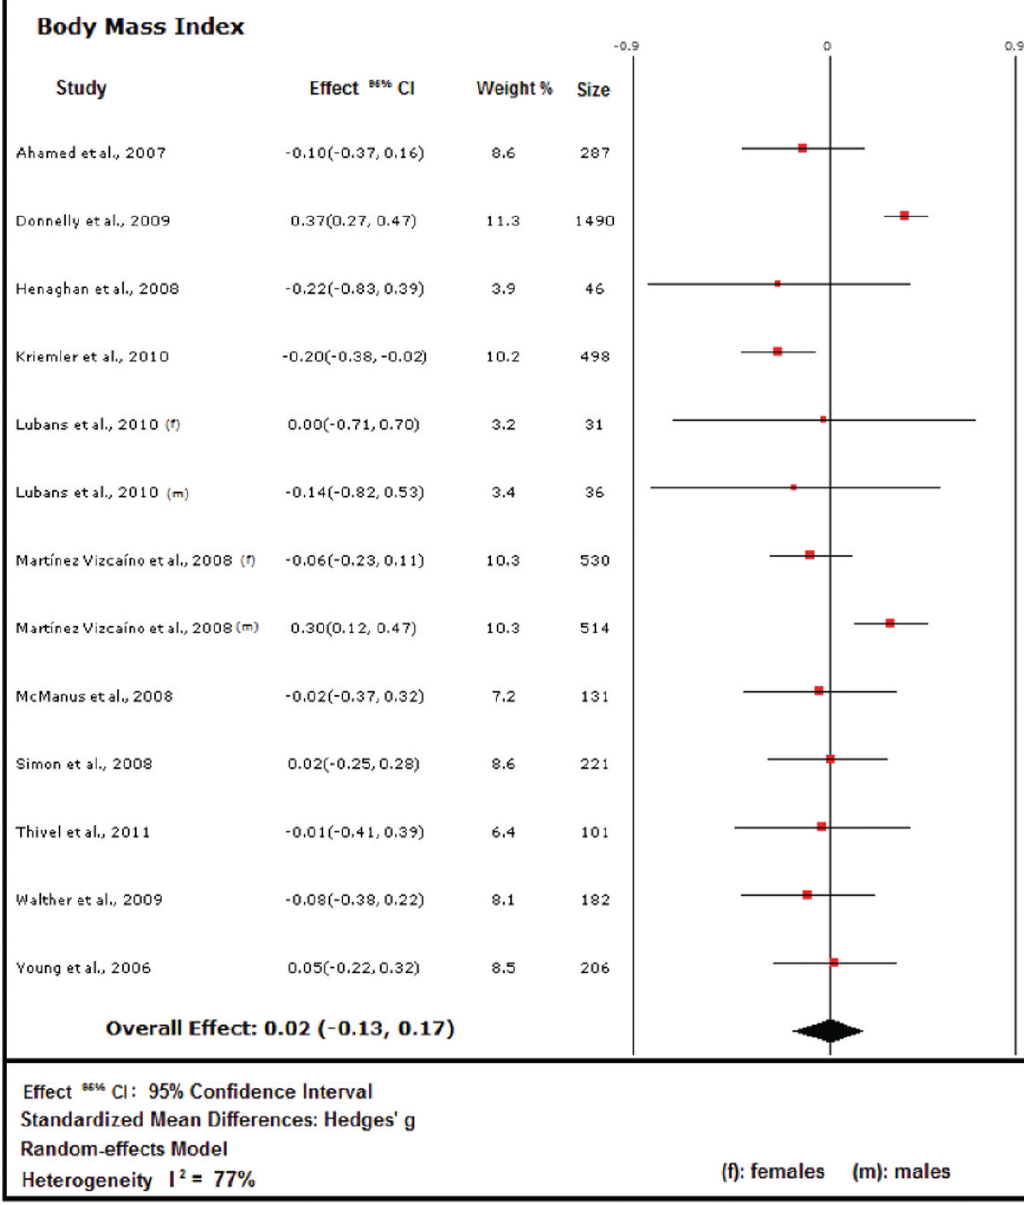
Figure 2 - Comparison of the effects of school-based interventions on the change in body mass index compared with